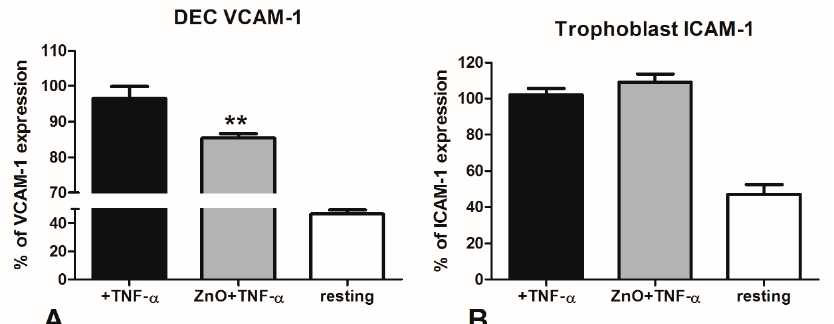
Figure 3. Analysis of vascular cell adhesion molecule-1 (VCAM-1) or intracellular adhesion molecule-1 (ICAM-1) expression on TNF- α stimulated placental cells. ( A ) Three di ff erent populations of DECs were incubated with 15 µ g / mL zinc oxide (ZnO) for 48 h and successively stimulated overnight (ON) with TNF- α . The expression of VCAM-1 was evaluated by an enzyme-linked immunosorbent assay (ELISA) on whole cells. Data are expressed as mean ± SE. ** p < 0.05, as compared to the untreated (Mann-Whitney test). The “ + TNF- α ” condition represents the VCAM-1 expression of DECs after stimulation with TNF- α , whereas resting condition is representative of the cells without any treatment. We considered the untreated “ + TNF- α ” condition as our reference value, indicated as 100%. ( B ) HTR8 / Svneo were incubated with 15 µ g / mL ZnO, successively stimulated ON with TNF- α and incubated with anti-human ICAM-1. Data are expressed as mean ± SE results from five experiments, each performed in triplicate. The Mann-Whitney test indicated that there are no statistical di ff erences (ns) between ZnO treated and untreated cells. The untreated “ + TNF- α ” condition represents the ICAM-1 expression of trophoblast cells after stimulation with TNF- α ; we considered this condition as our reference value, indicated as